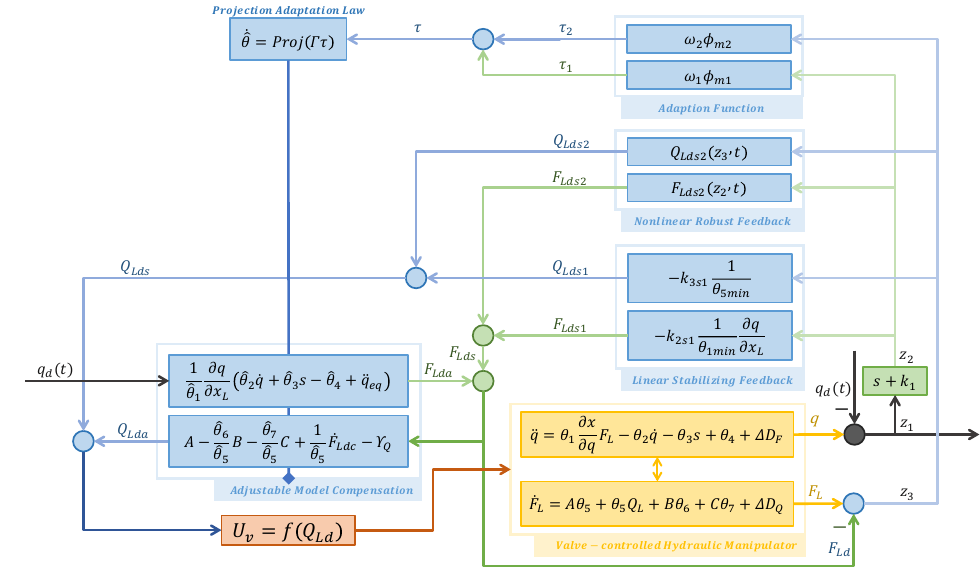
Figure 2. The structure of the ARC